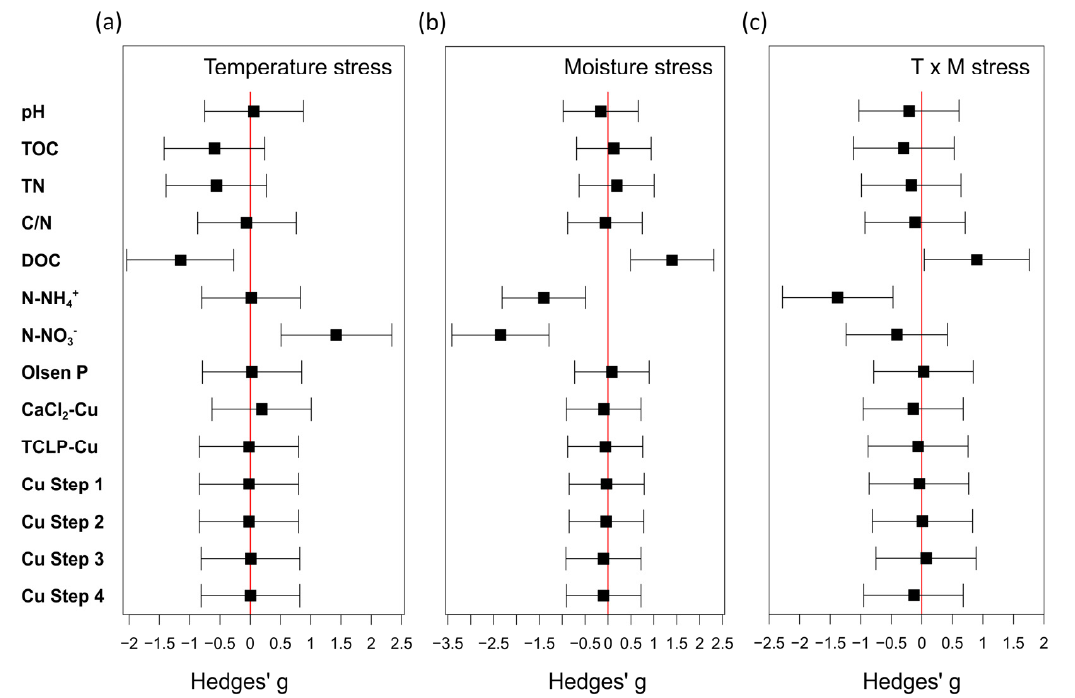
Figure 4. Changes of soil properties due to temperature stress ( a ), moisture stress ( b ), or their combination ( c ). Effect sizes (g) lower than 0.2 are considered not meaningful. Positive or negative mean effect sizes indicate an increase or a decrease of the soil property after the stress, respectively. Changes are shown using forest plots of mean effect sizes, based on Hedges’ g index.